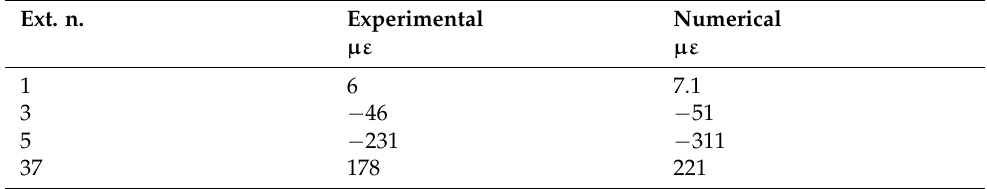
Table 6. Comparison between the experimental strain at the maximum load along with numerical strain for the concentrated bending evaluated for a selected list of strain gauges. Ext. n.